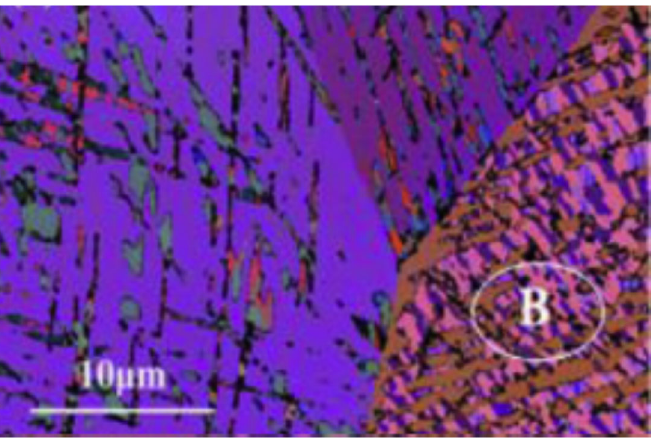
Figure 7. Grain orientation after three LSP passes [87].